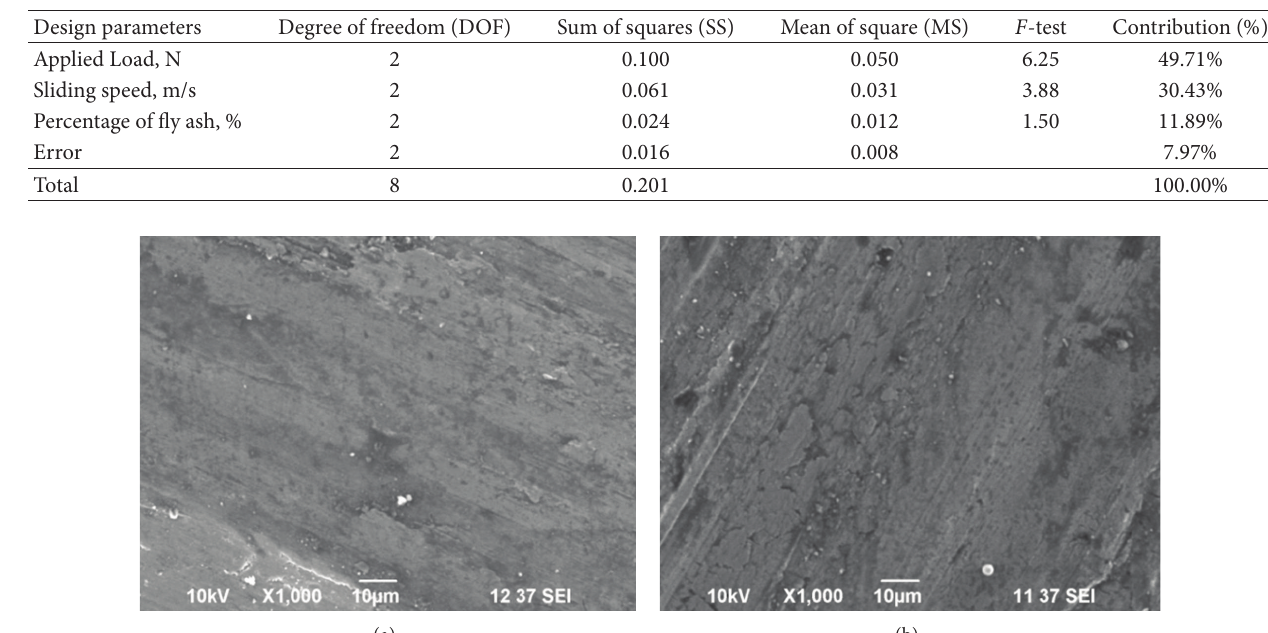
F 4: (a) SEM of worn surface with grooves. (b) SEM of worn surface with grooves and damages.